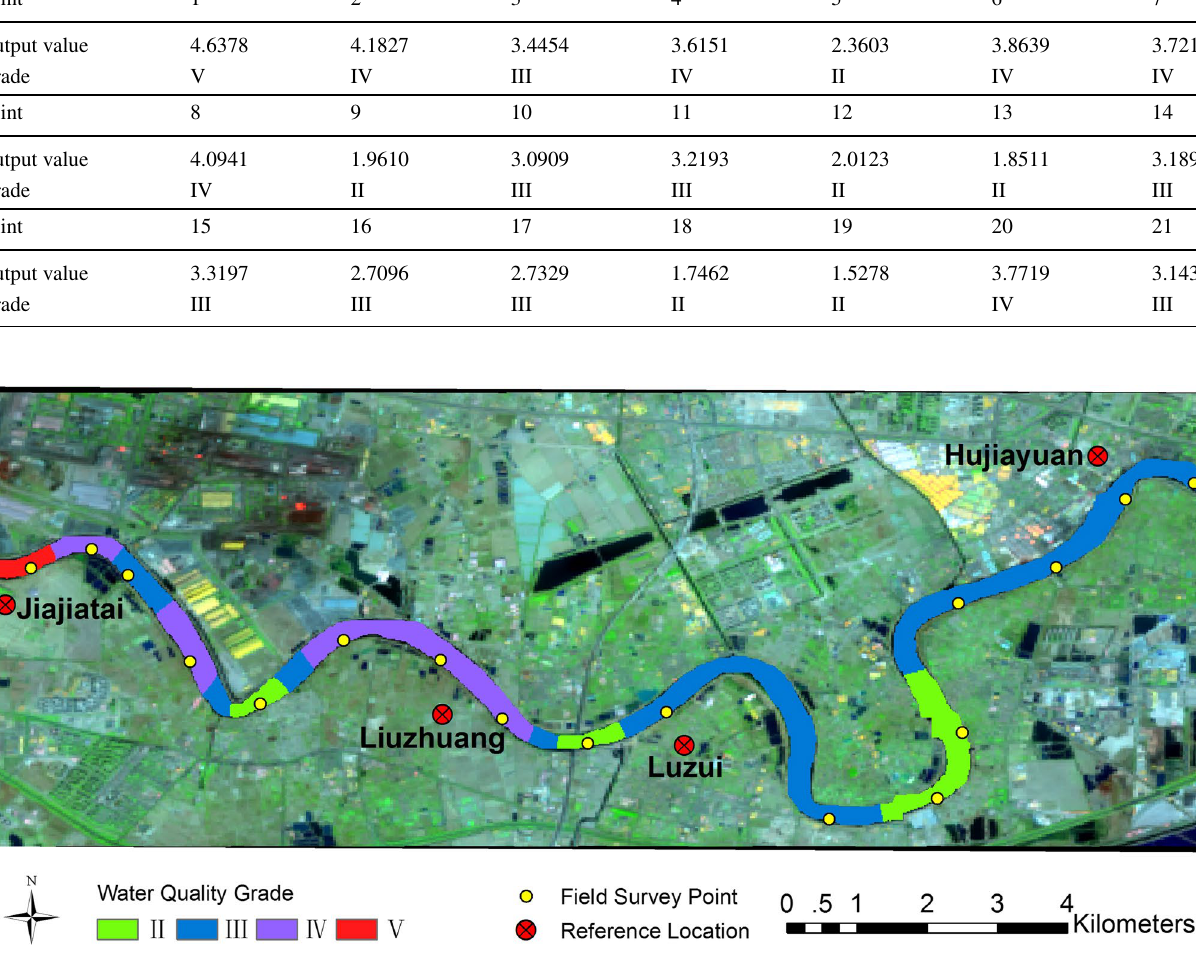
Table 4 Evaluation grading of surface water quality based on GA-BP neural network Point